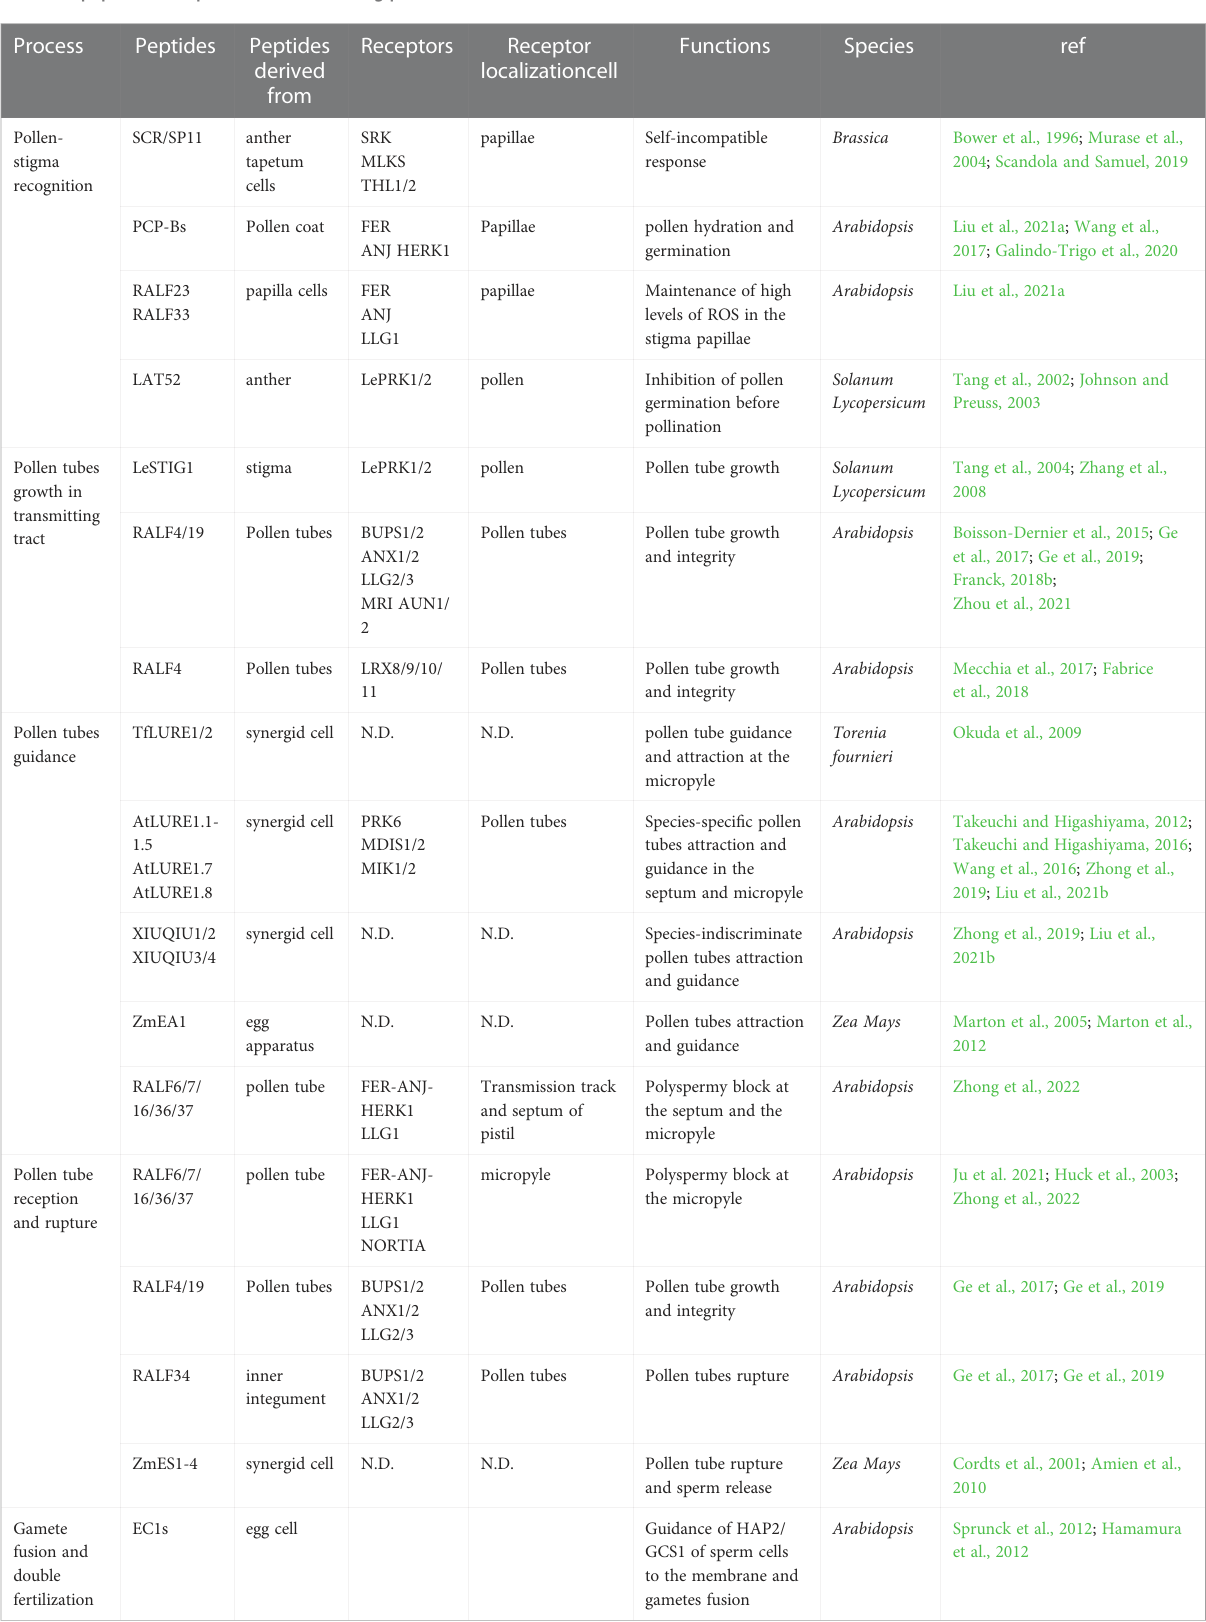
TABLE 1 peptides, receptors, functions during plant